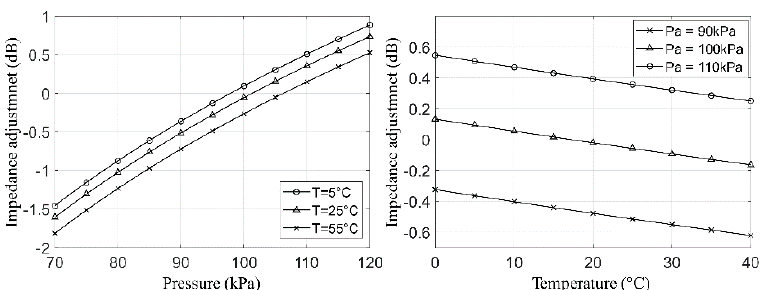
Figure 3. Meteorological effects on aircraft noise intensity. Impedance adjustment as a function of the atmospheric pressure and temperature.